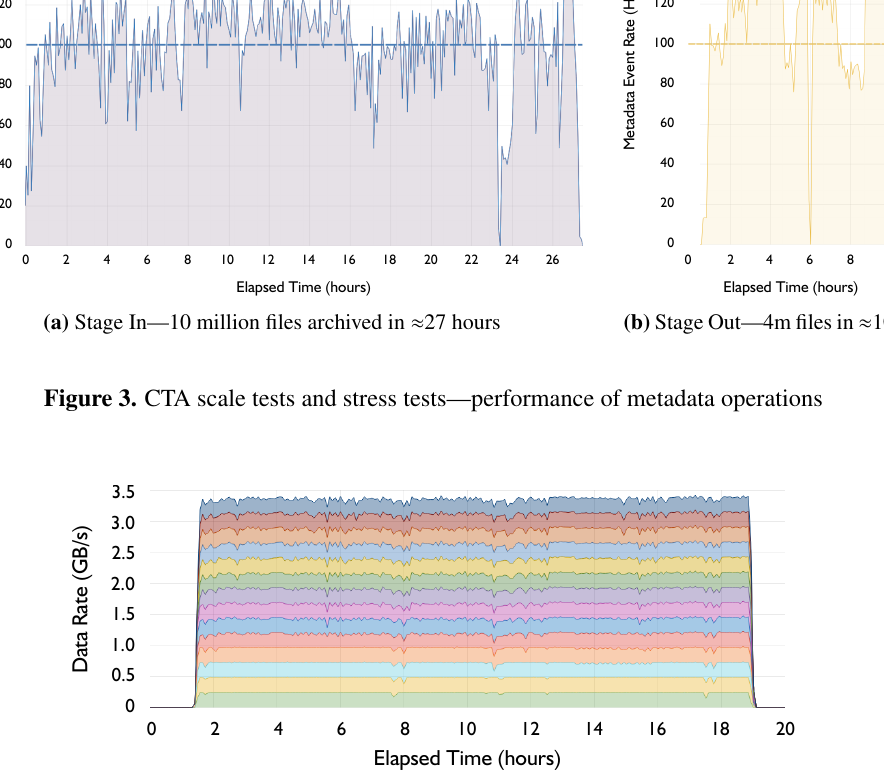
Figure 4. CTA data transfer rates during the Heavy Ion Data Challenge with 14 tape drives (Sept.